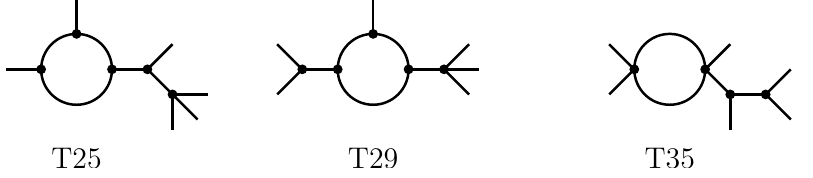
Figure 16 . Topologies, which lead to a d = 7 tree level neutrino mass. For each of these topologies one can construct diagrams, which have a d = 5 tree-level mass. All remaining diagrams contain the scalar S ( 4 S ) along with the fermion (cid:9) ( 3 F ) ((cid:12)gure 1) 1 3 = 2